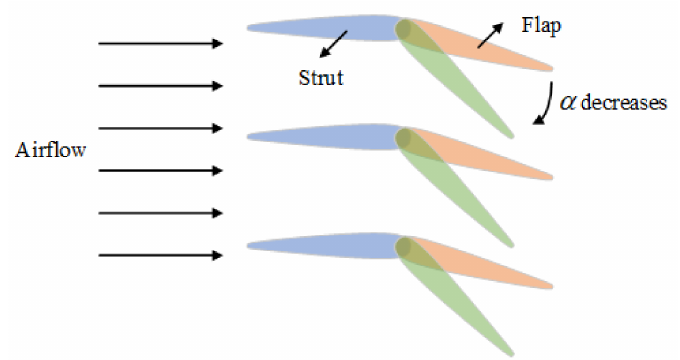
Figure 14. Schematic diagram of guide vane angle